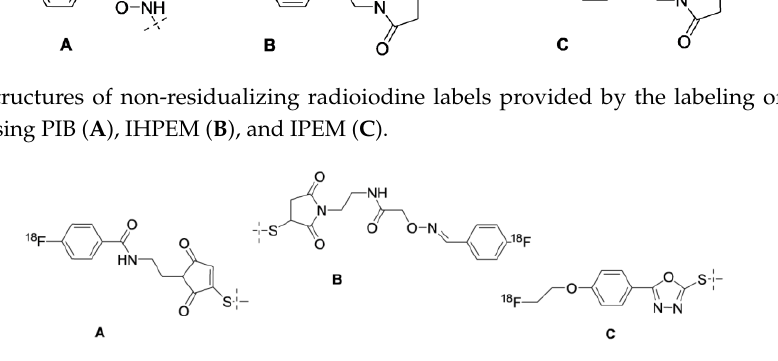
Figure 3. Structures of non-residualizing radiofluorine labels provided by the labeling of affibody molecules using FBEM ( A ), FBA ( B ), and FPOS ( C ).